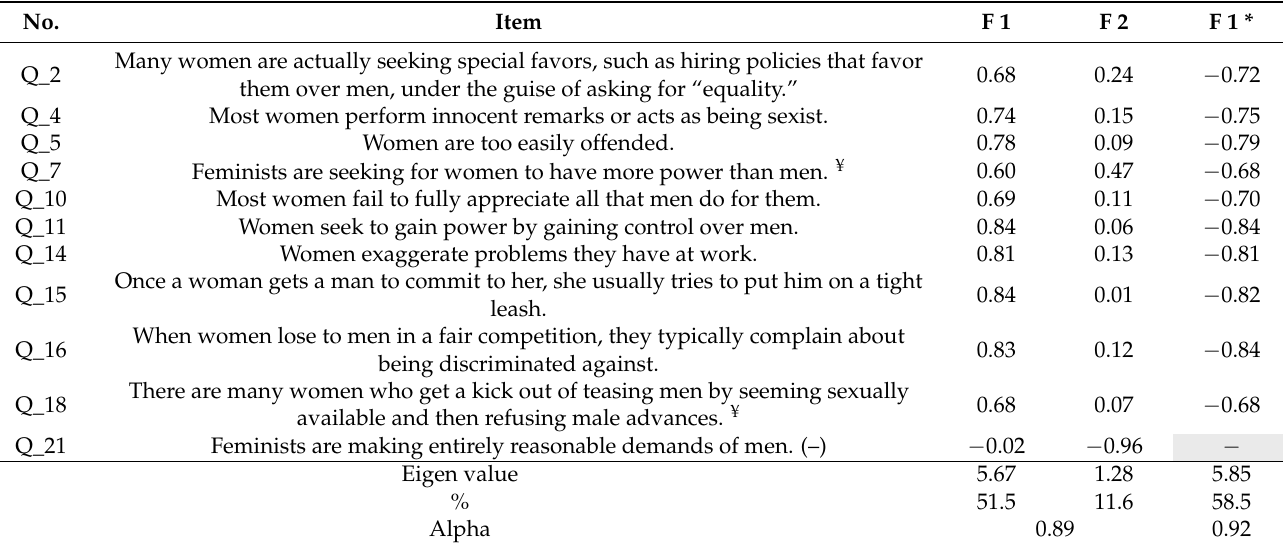
Table 1. Structural and metric characteristics of the Hostile Sexism ( HS ) scale before and after item selection.